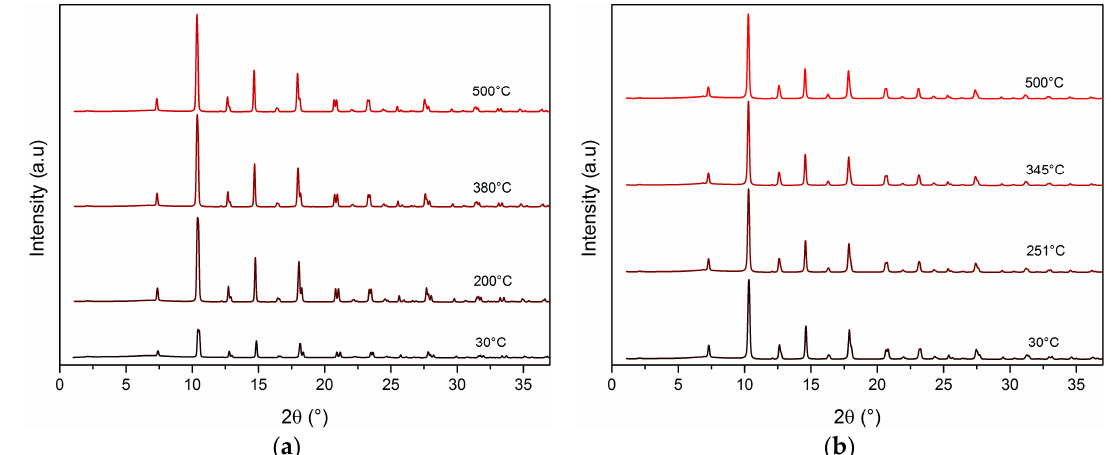
Figure 3. XRD patterns ( λ = 0.49324 Å) recorded in situ during pretreatment of: ( a ) LaCoO 3 ; ( b ) LaMnO 3 perovskites.